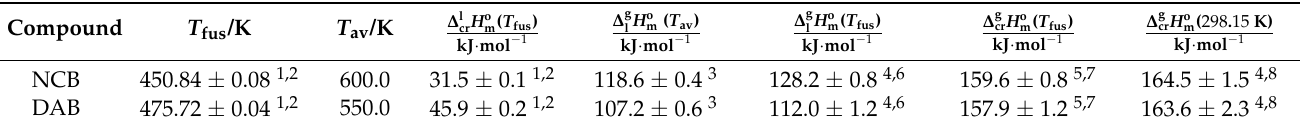
Table 5. Values of fusion and vaporization enthalpies obtained at the experimental temperature for the two nitrogen compounds, and vaporization and sublimation enthalpies at the melting temperature and sublimation enthalpies at T = 298.15 K and p ◦ = 0.1